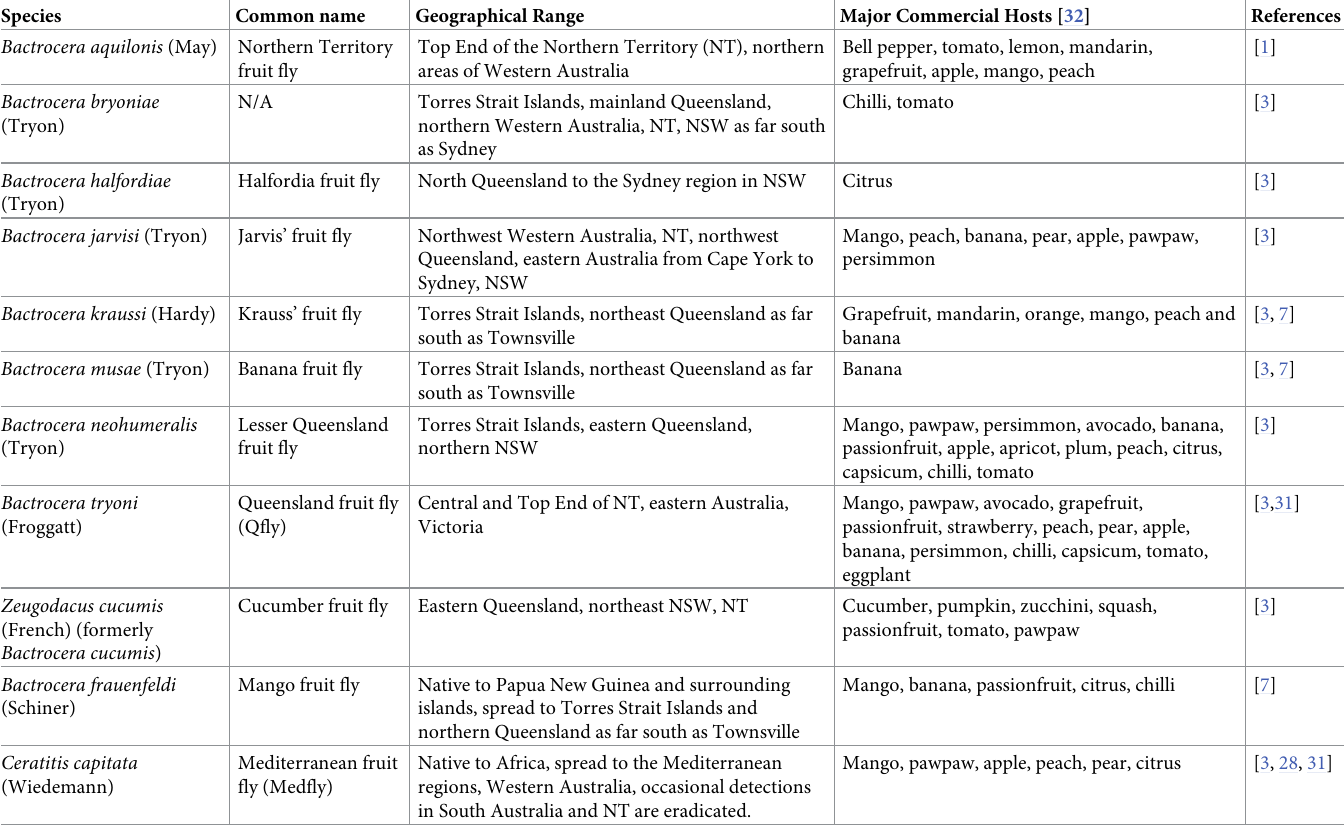
Table 1. Eleven economically-significant tephritid pest species present in